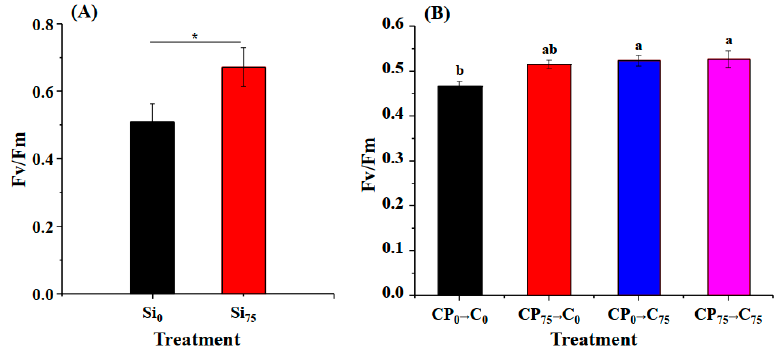
Figure 4. The Fv/Fm of poinsettia subjected to high ( A ) and low ( B ) temperature stresses. The asterisk and different letters besides error bars indicate significant differences according to Student’s t -test and Duncan’s test, respectively ( p ≤ 0.05). Si 0 , 0 mg ∙ L − 1 Si; Si 75 , 75 mg ∙ L − 1 Si; CP 0 → C 0 , grown with 0 mg ∙ L − 1 Si during cutting propagation and cultivation; CP 75 → C 0 , grown with 75 mg ∙ L − 1 Si during cutting propagation and 0 mg ∙ L − 1 Si during cultivation; CP 0 → C 75 , grown with 0 mg ∙ L − 1 Si during cutting propagation and 75 mg ∙ L − 1 Si during cultivation; CP 75 → C 75 , grown with 75 mg ∙ L − 1 Si during cutting propagation and 75 mg ∙ L − 1 Si during cultivation.